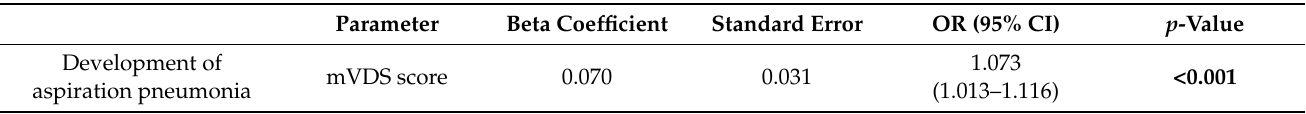
Table 4. Univariate logistic regression analysis (with the enter method) of the association between the modified version of the Videofluoroscopic Dysphagia Scale and the development of aspiration